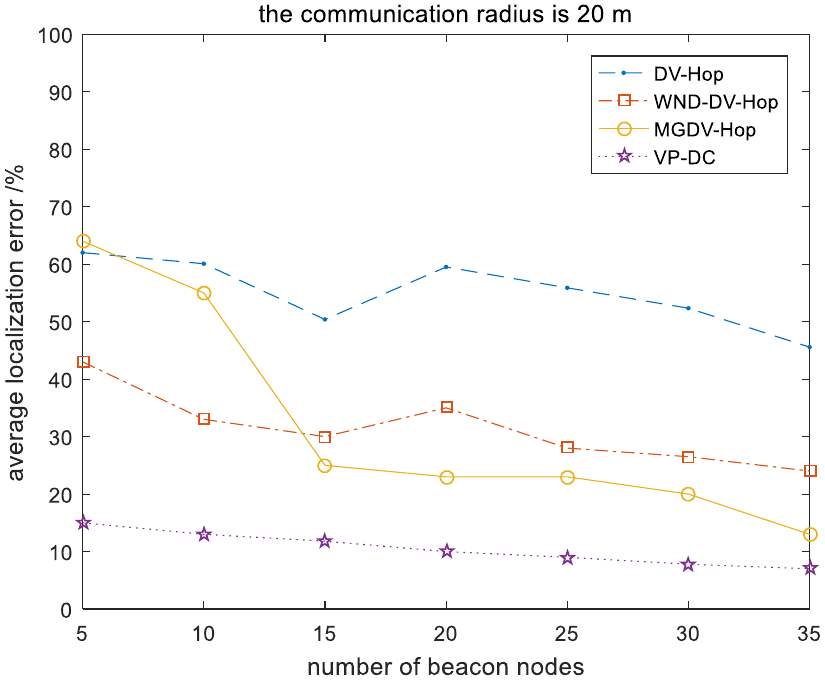
Figure 7. Relationship between the number of beacon nodes and the average localization error.